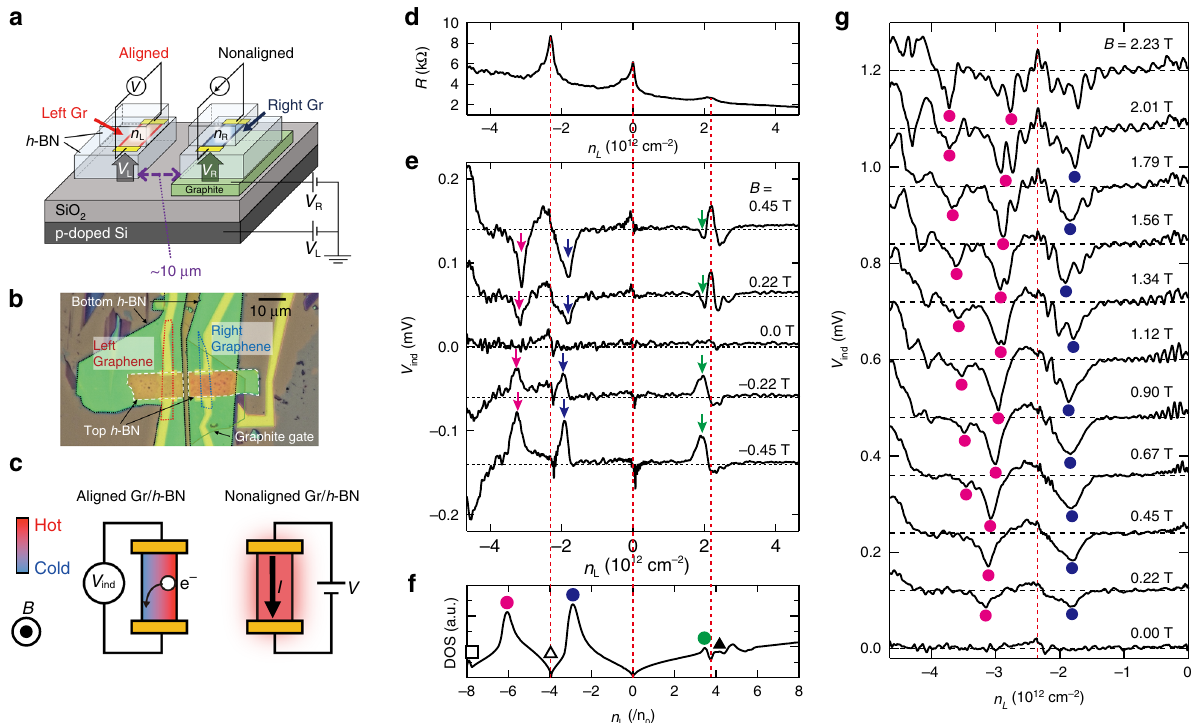
Fig. 2 Magnetothermoelectric measurement of graphene/ h -BN moiré superlattice. a Schematic of the device structure. The lattice of the graphene (Gr) on the left is aligned with the underlying h -BN to achieve a moiré pattern ( θ ~ 0°). As the graphene on the right is not aligned with the h -BN lattice, the in fl uence of moiré is negligible. The graphene on the right has a graphite gate (GrG) underneath, which can apply a local back-gate voltage of V R to control its carrier density n R ; the carrier density of the graphene on the left n L is controlled using the back-gate voltage V L . b Optical micrograph of fabricated device. c Schematic illustration of thermoelectric voltage detection in a parallel graphene device. d Two-terminal resistance R of the graphene on the left as a function of its carrier density n L at 2.0 K. e Thermoelectric voltage V ind generated in the graphene on the left as a function of its carrier density n L , measured at a different out-of-plane magnetic fi eld B = ±0.45, 0.22, and 0 T. A constant power P of 1 mW is applied to the graphene on the right. Traces are offset for clarity and offset is depicted by black dashed lines. Signals appear at a position away from the SDPs are indicated by the magenta, blue, and green arrows. f Calculated DOS with respect to normalized carrier density n / n 0 derived from Fig. 1e. De fi nition of solid and open circles, triangles, and square are same as Fig. 1e. g V ind as a function of the carrier density n L measured at a different out-of-plane magnetic fi eld B obtained from the graphene/ h - BN moiré superlattice at 2.0 K. Here, the positions of signal dips are indicated by solid magenta circles (second hole-side vHS) and solid blue circles ( fi rst hole-side vHS), respectively. The dashed vertical red line depicts the carrier density of the SDP(h). Traces are offset for clarity and offset is depicted by black horizontal dashed magnetothermoelectric measurement, as schematically illustrated in Fig. 2a; the optical micrograph of the device is shown in Fig. 2b. Two different fl akes of graphene encapsulated with h -BN were placed on the SiO 2 /doped-Si substrate. We created trench in the h -BN to reduce capacitive coupling between the two graphene fl akes (see Methods section and Supplementary Note 3). The graphene depicted on the right has a graphite gate (GrG), which can apply a local back-gate voltage of V R to control the carrier density n R . The carrier density of the graphene on the left n L is controlled using the back-gate voltage V L . The lattice of the graphene on the left is aligned with the underlying h -BN sub- strate, to ensure a large period of moiré potential. In contrast, the period of the graphene on the right is small because of the sig- ni fi cant rotational misalignment between graphene and h -BN. As illustrated in Fig. 2c, the nonaligned graphene is used as a local heater by applying current to induce Joule heating. The heat radiated from the nonaligned graphene induces heating of the aligned graphene, thereby creating a temperature gradient per- pendicular to the channel of the aligned graphene. In the presence of this temperature gradient and the magnetic fi eld perpendicular to the plane B , thermoelectric voltage V ind is generated along the channel direction of the aligned graphene, due to the Nernst effect 20 – 24 . This voltage can be detected using the metal electrode